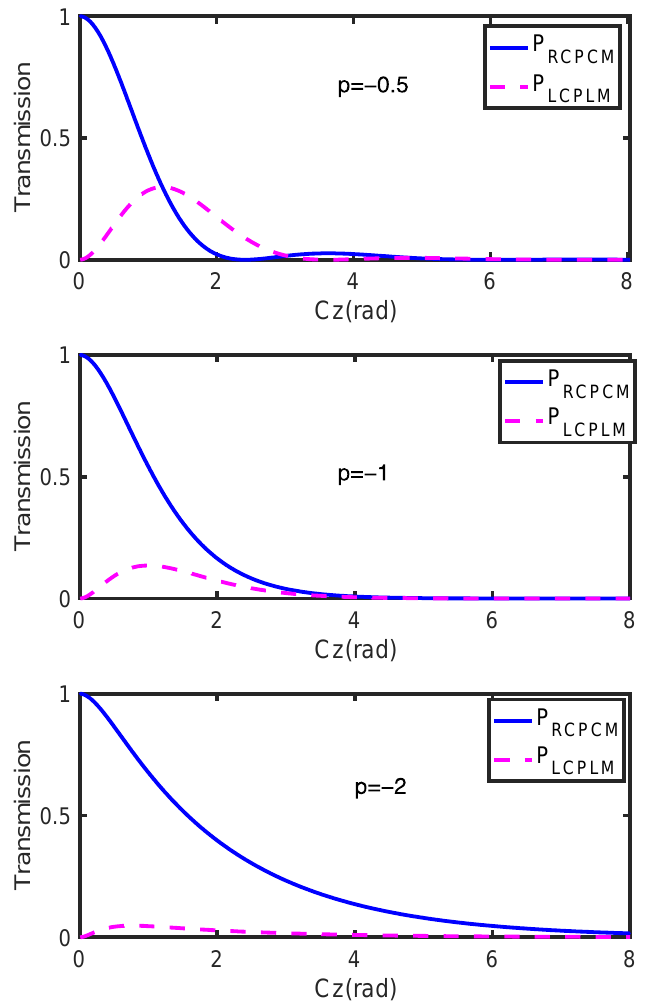
Figure 2. Transmission of the RCPCM and LCPLM with different loss factors p . However, the analytical solutions, Equations (5)–(7), and the corresponding trans- mission simulations are obtained under the phase-matching condition, which can only be fulfilled at certain wavelengths. To study the coupling process when the phase-matching condition is not fulfilled, we define a detuning factor q = δ /2 C and simulate the trans- mission of the RCPCM with a loss factor p for different detuning factors q , as shown in Figure 3. The highest coupling efficiency occurs at q = 0, where the phase-matching condi- tion is strictly fulfilled; when q increases, indicating that the coupling gradually deviates from phase-matching condition, the coupling efficiency decreases. The variation of the transmission of RCPCM with p is not as explicit as that with q , but the variation trend coincides with the analytical solutions in Equations (5)–(7). Overall, the transmission of the RCPCM decays fastest when the loss factor p is approximately − 0.9 for various q , as indicated by the oval in Figure 3. Hence, to achieve the desired coupling efficiency within a short coupling length, the loss factor p must be set around − 0.9. To further validate this point, we simulated the transmission spectra of a coated uniform CLPG with different loss factors p , as shown in Figure